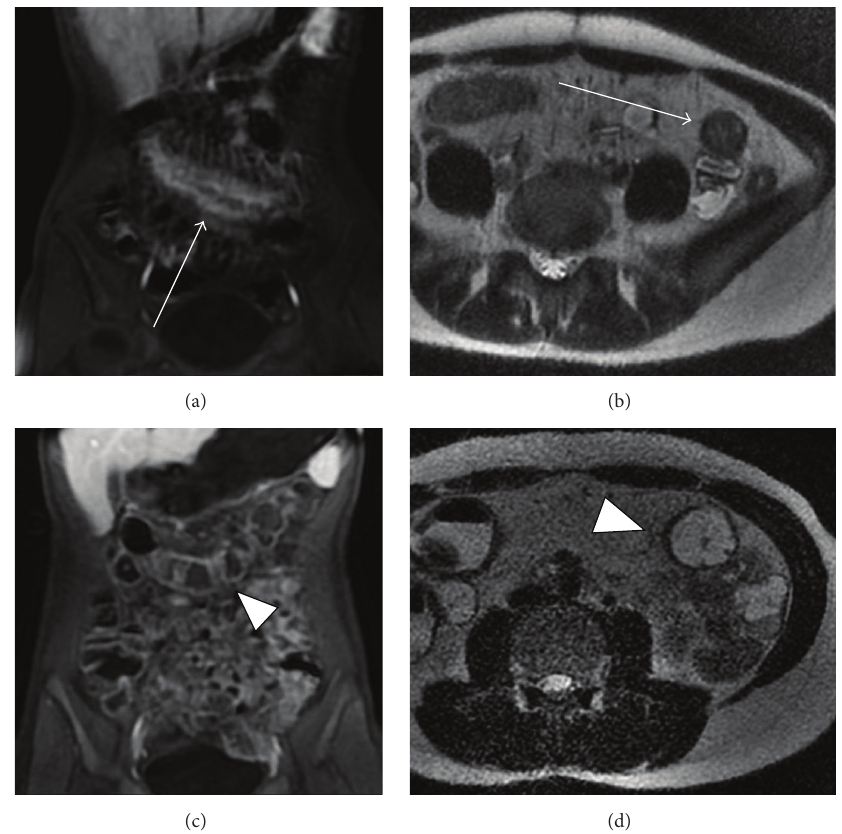
Figure 2: Mucosal healing on serial MRE in a patient with Crohn’s disease affecting the transverse colon. (a) Coronal T1-weighted postgadolinium with fat saturation and (b) axial T2-weighted images demonstrating bowel wall thickening, mural edema, mucosal hyperenhancement, and the comb sign (arrows) on initial imaging. Subsequent MRE performed after treatment ((c) and (d)) demonstrates normalization of imaging findings (arrowheads) correlating with mucosal healing at